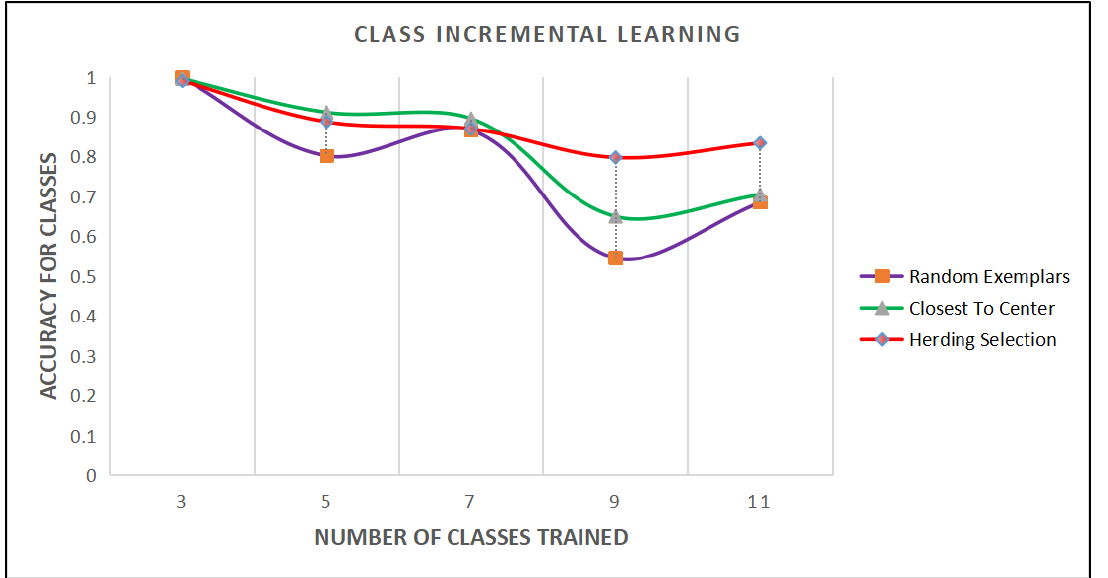
Figure 7. Incremental learning evaluation: comparison of sample selection strategies.